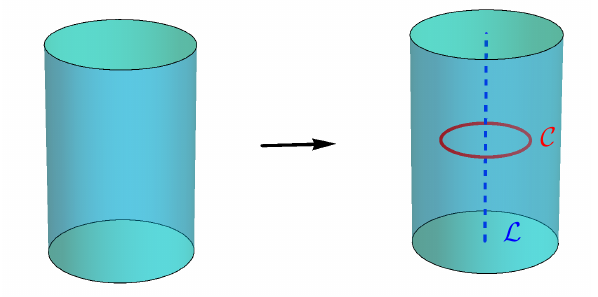
Figure 1 . A large gauge transformation produces a Dirac string singularity along the dotted line L , which is however invisible as any Wilson loop encircling it along C is